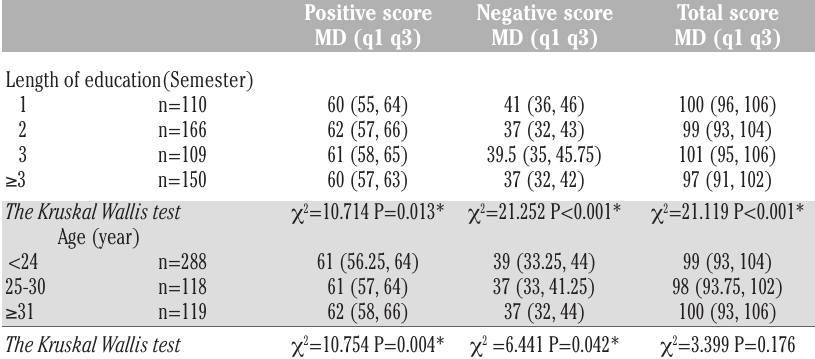
Table 2. Positive score, negative score and total score across length of education and age